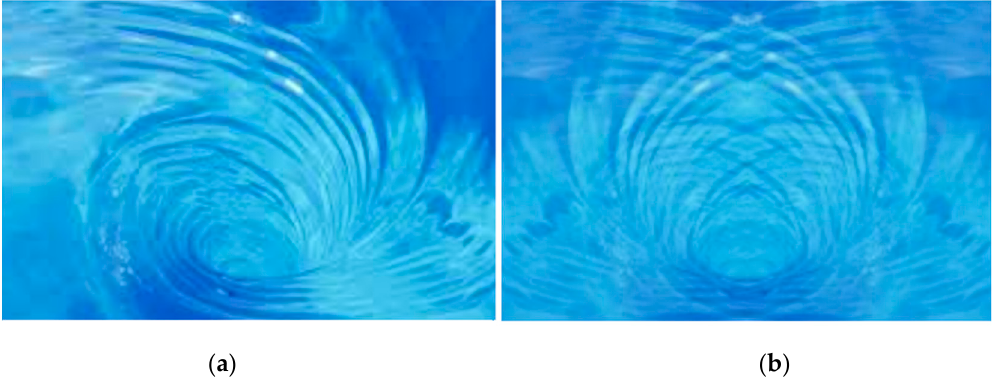
Figure 19. ( a ) The shape of streamlines in the vortex. ( b ) The mirror image laid over the original one creates the shape of the Michell beam.